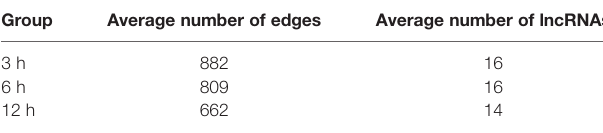
TABLE 1 | Average number of edges and lncRNAs in